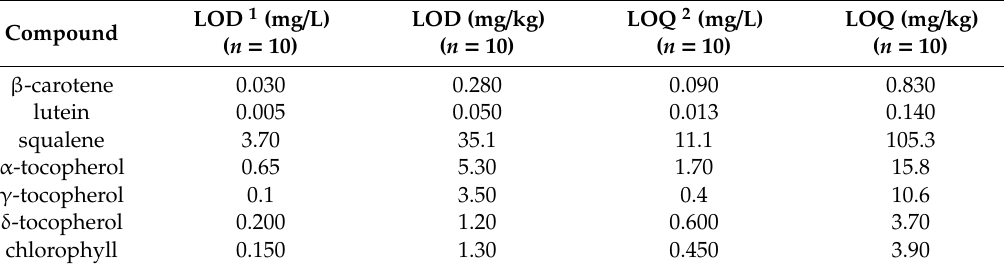
Table 5. Limit of detection (LOD) and limit of quantitation (LOQ) of each